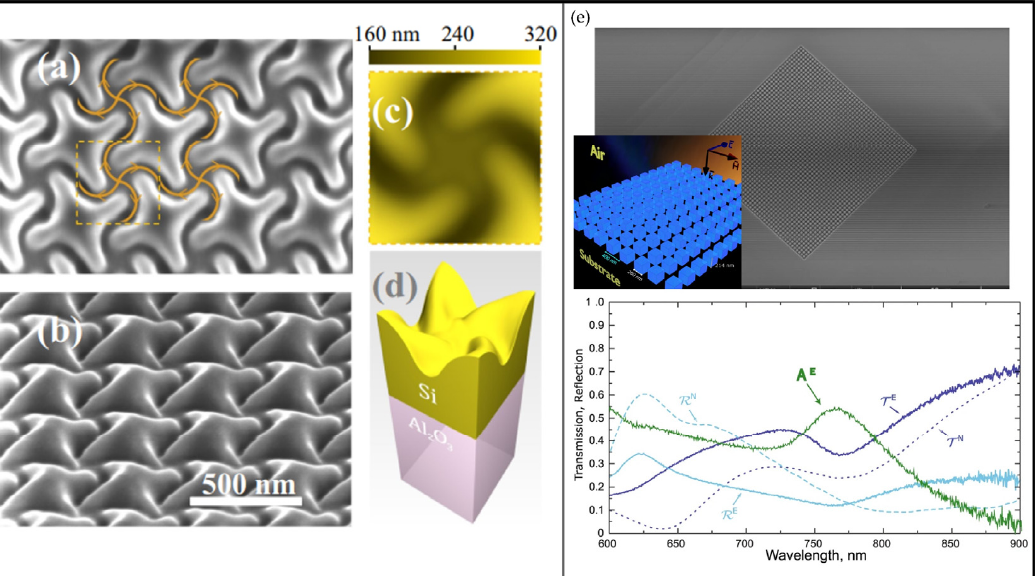
Figure 7. ( a – d ) The schematic diagram and SEM image of chiral visible light Si metasurface by FIB. Reprinted from [112]. CC BY 4.0; ( e ) the SEM of Si parallelepiped metasurface, and the transmission and reflection spectra of the metasurface. Reprinted from [113]. CC BY 4.0.